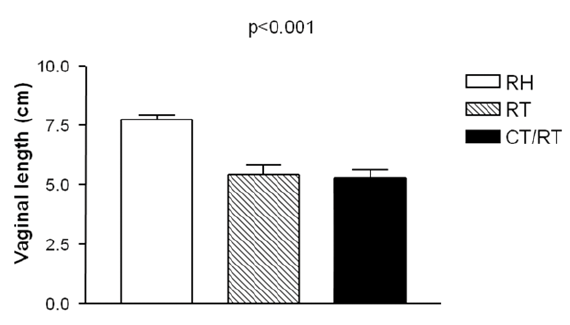
Figure 2 - Vaginal length according to treatment